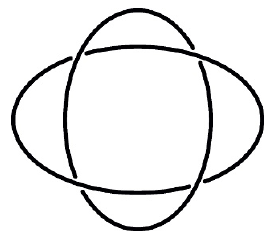
Figure 4 . The T (2 ; 4)